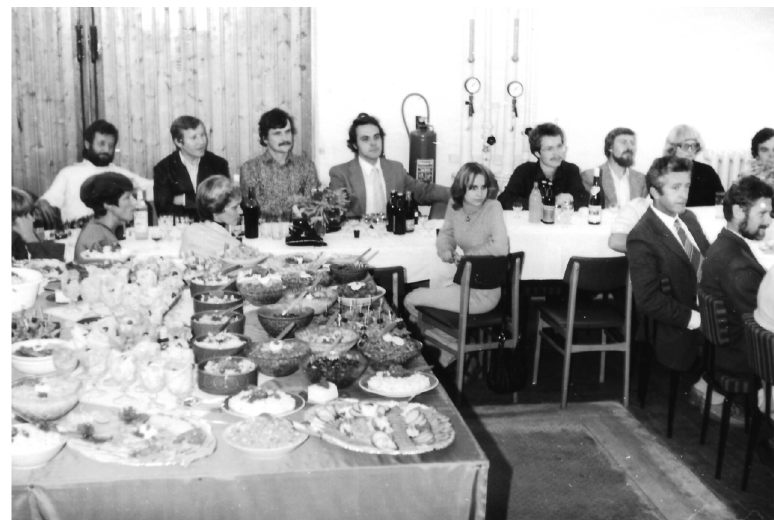
Figure 15. The colleagues celebrate this habilitation.